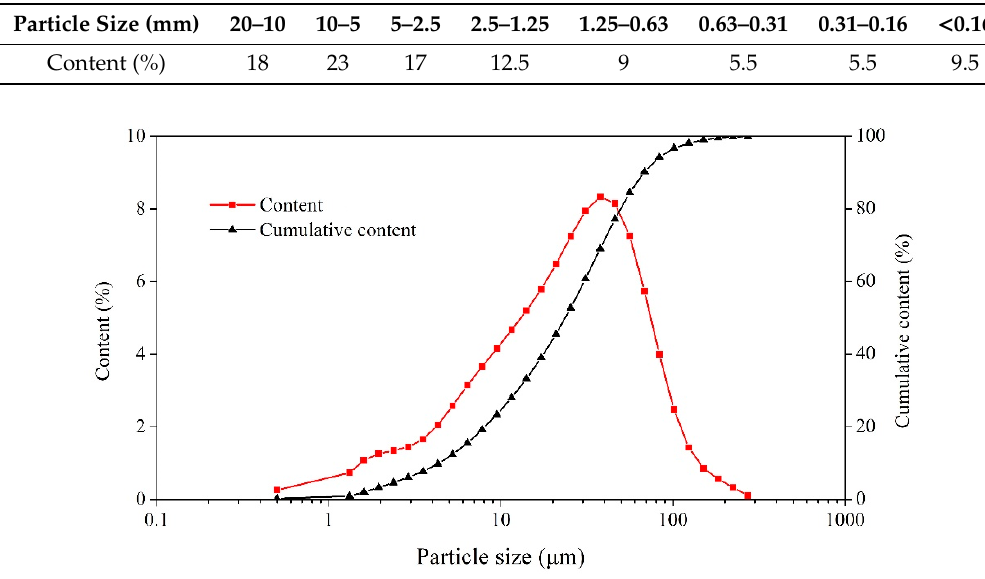
Figure 4. The particle size distribution of fly ash.